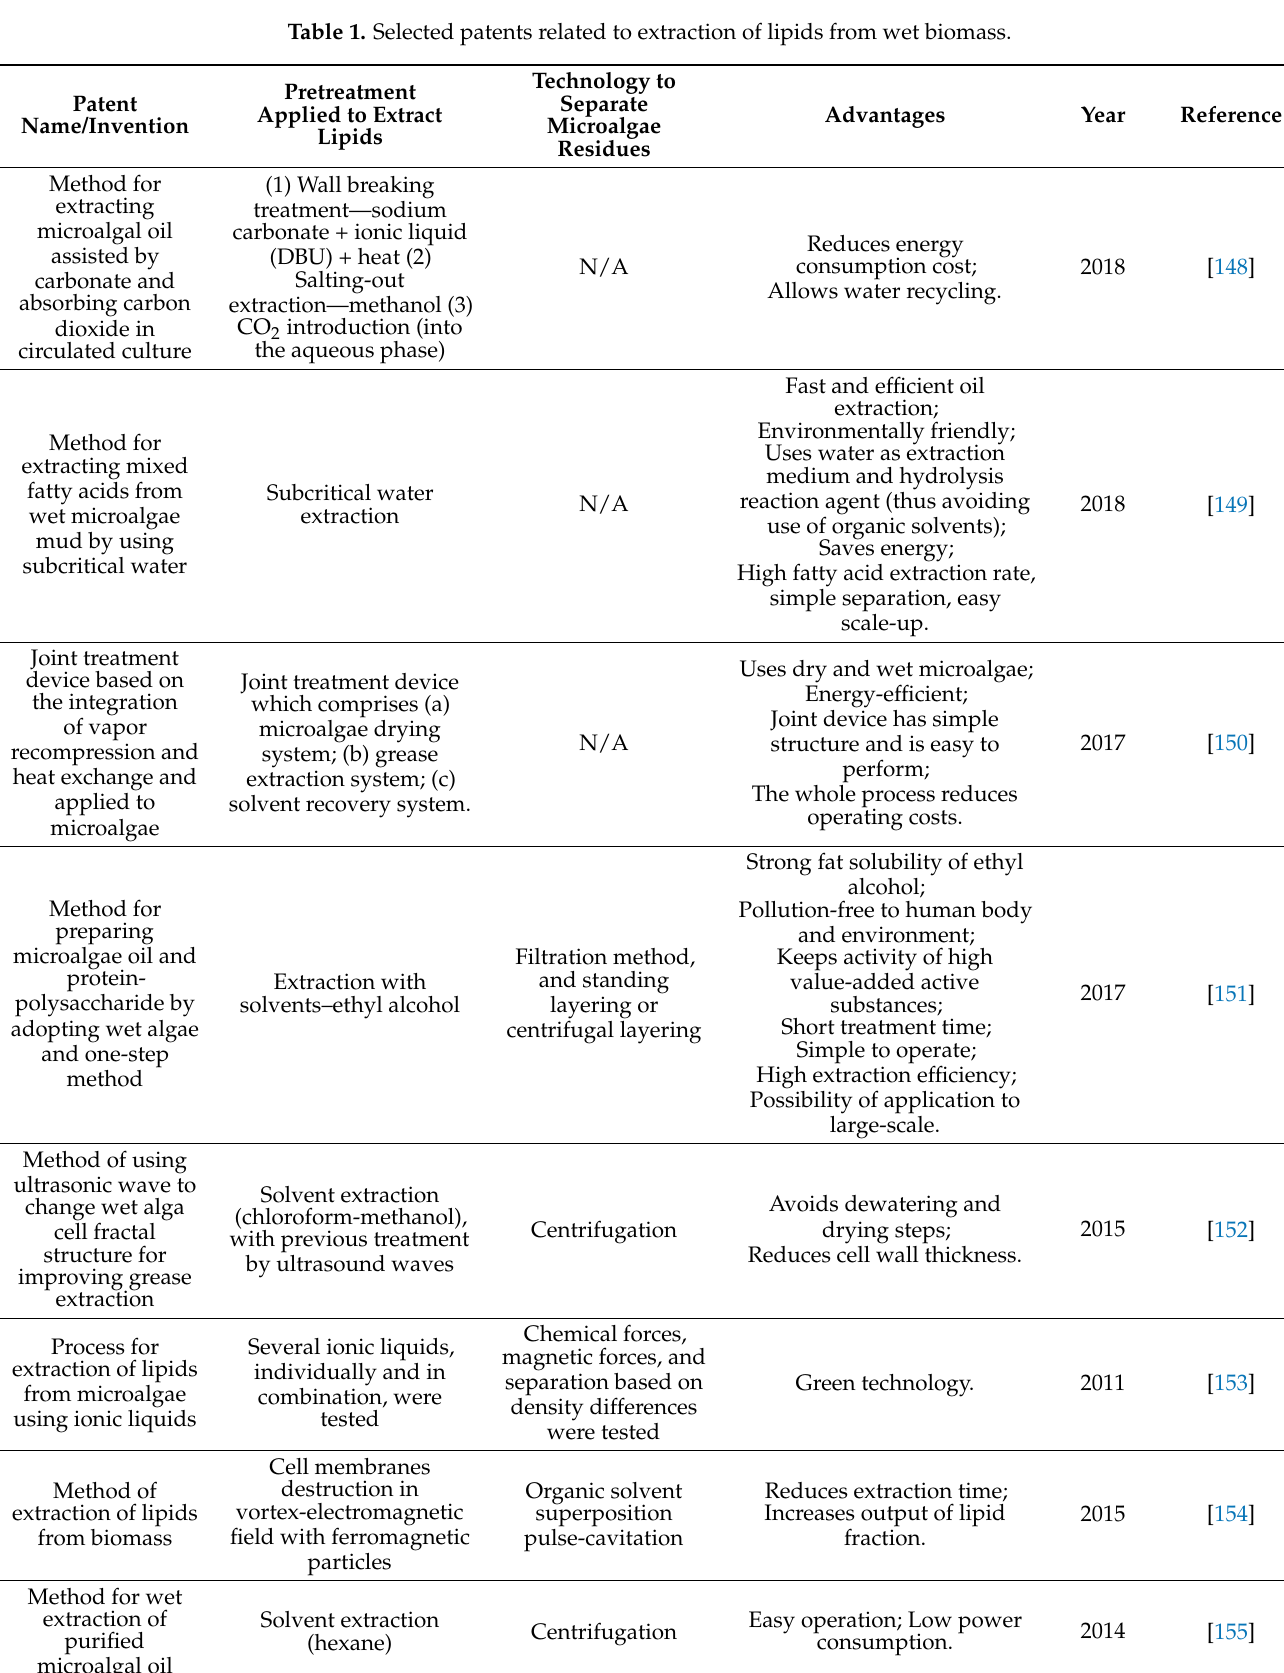
Table 1. Selected patents related to extraction of lipids from wet